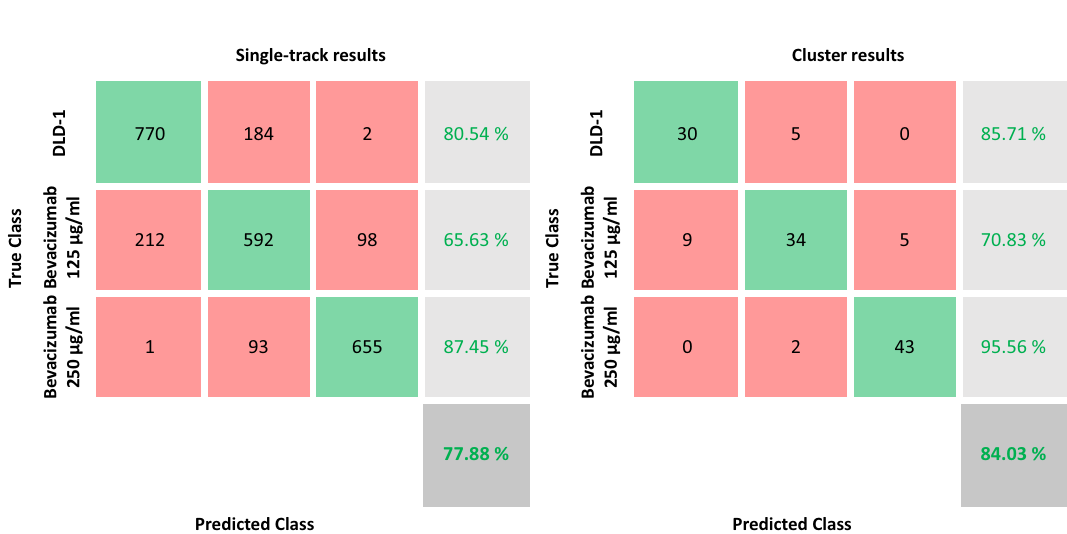
Figure 3. Confusion matrices of the classification task in case study 2. Single cell results (left) and cluster results (right). Third column represents in turn from top to bottom: ratio of DLD1 correctly recognized, ratio of Bevacizumab 125 μg/ml correctly detected, ratio of Bevacizumab 250 μg/ml correctly detected, unbalanced accuracy (ratio of the sum of true instances over the total number of